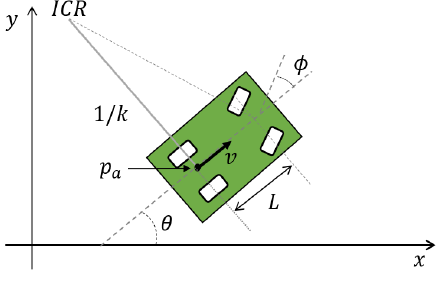
Figure 2. Kinematic model of the car-like robot. States are given by the center position of rear wheel axle p a , the orientation angle θ , the steering angle φ . L represents the wheelbase of the car. Robot velocity v is in the direction of rear wheels. ICR: Instantaneous Center of